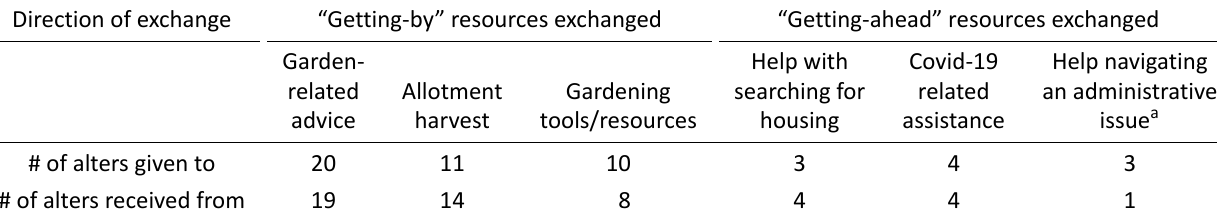
Table 2. Observed resource transfers with contacts formed in the